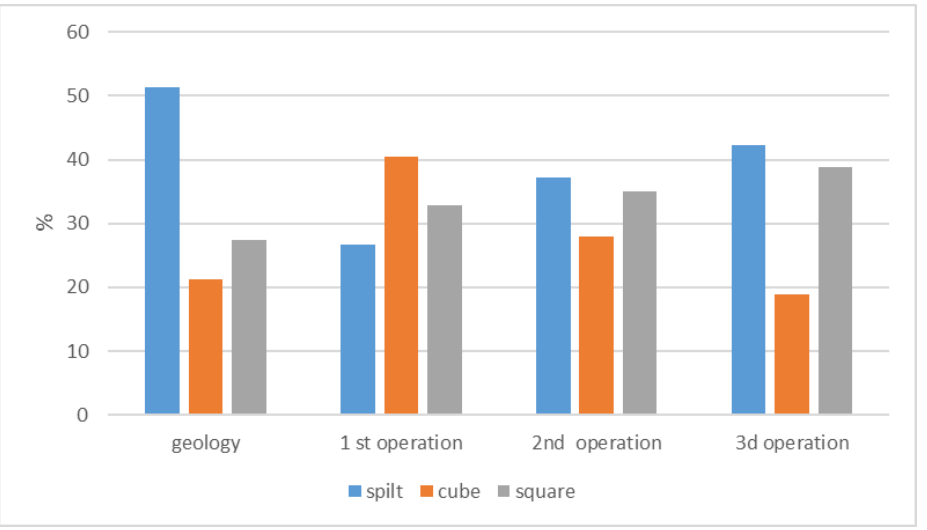
Figure 7. The experimental results: general fragment form distribution (mean values for three ex- periments).